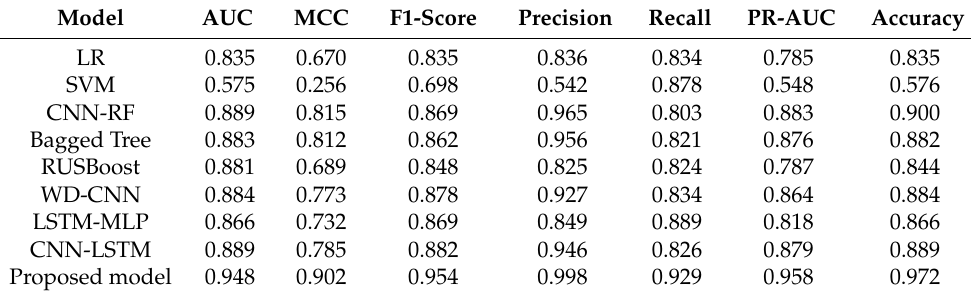
Table 7. Proposed model’s performance comparison with conventional schemes for